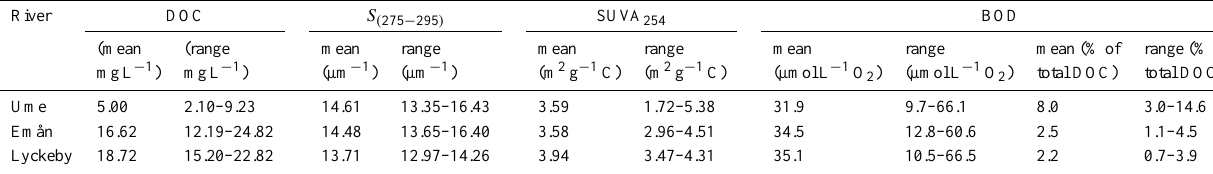
Table 2. Organic matter characteristics for the three catchments. River